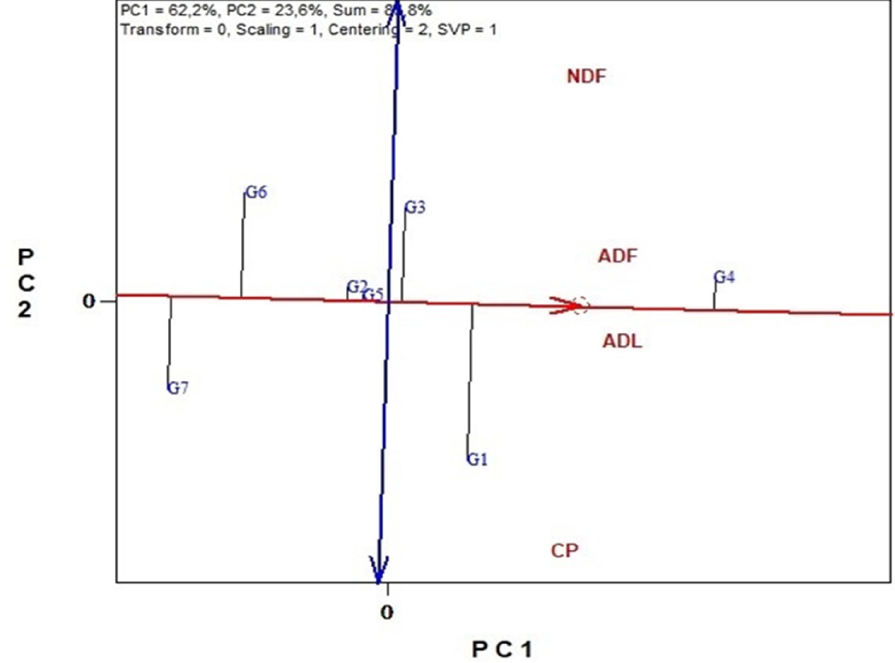
Figure 7. The “Mean vs. Stability” view of the GGE biplot for seven genotypes of V. sativa of four nutritional traits, averaged across six environments.